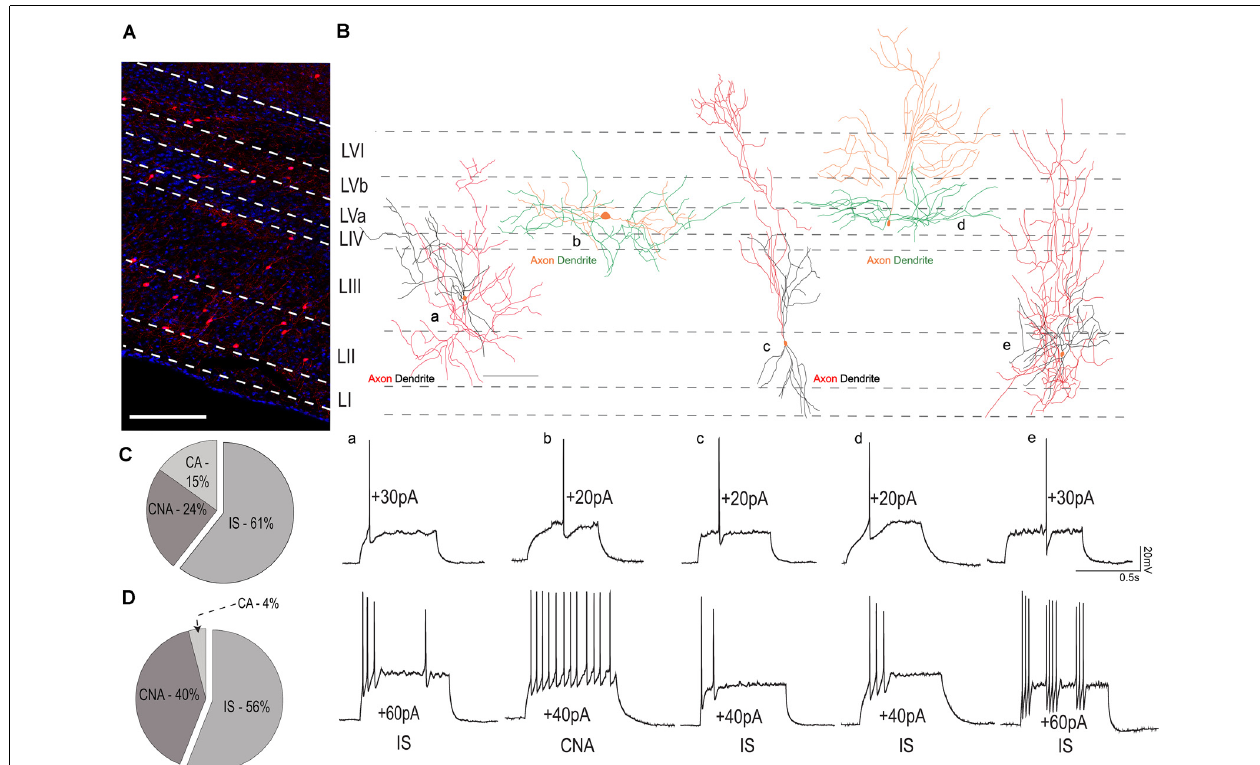
FIGURE 4 | Variability in firing patterns of VIP cells from layers I-III and IV-VI. (A) Distribution of VIP cells (tdTom) in the MEC, the layers have been marked using DAPI as reference. The scale bar is 500 µ m. (B) The reconstructed morphology of five individual VIP cells is shown in a schematic of the MEC. For all cells, somas are colored in orange. For cells recorded in superficial MEC axonal and dendritic processes are colored in red and black, respectively. For cells recorded from layers IV-VI, axons are in orange while dendrites are colored green. Below, electrophysiological recordings from the respective cells at rheobase (upper trace) and action potential firing pattern at suprathreshold current (lower traces). The scale bar in (B) is 100 µ m. Percentages of various firing patterns observed in the (C) superficial layers of the MEC and (D) deep layers of the MEC. Abbreviations name the firing pattern after the Petila convention (Ascoli et al., 2008; IS, Irregular spiking; CA, Continuous adapting; CNA, continuous